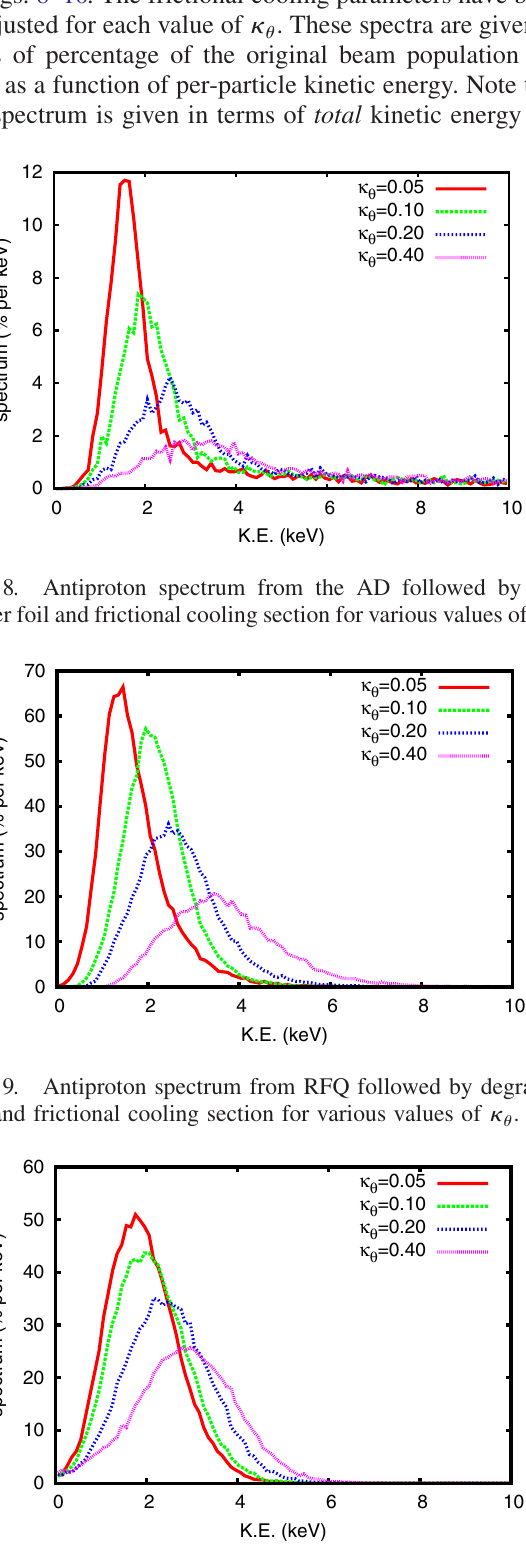
FIG. 10. Antiproton spectrum from ELENA followed by de- grader foil for various values of (cid:10) (cid:9)